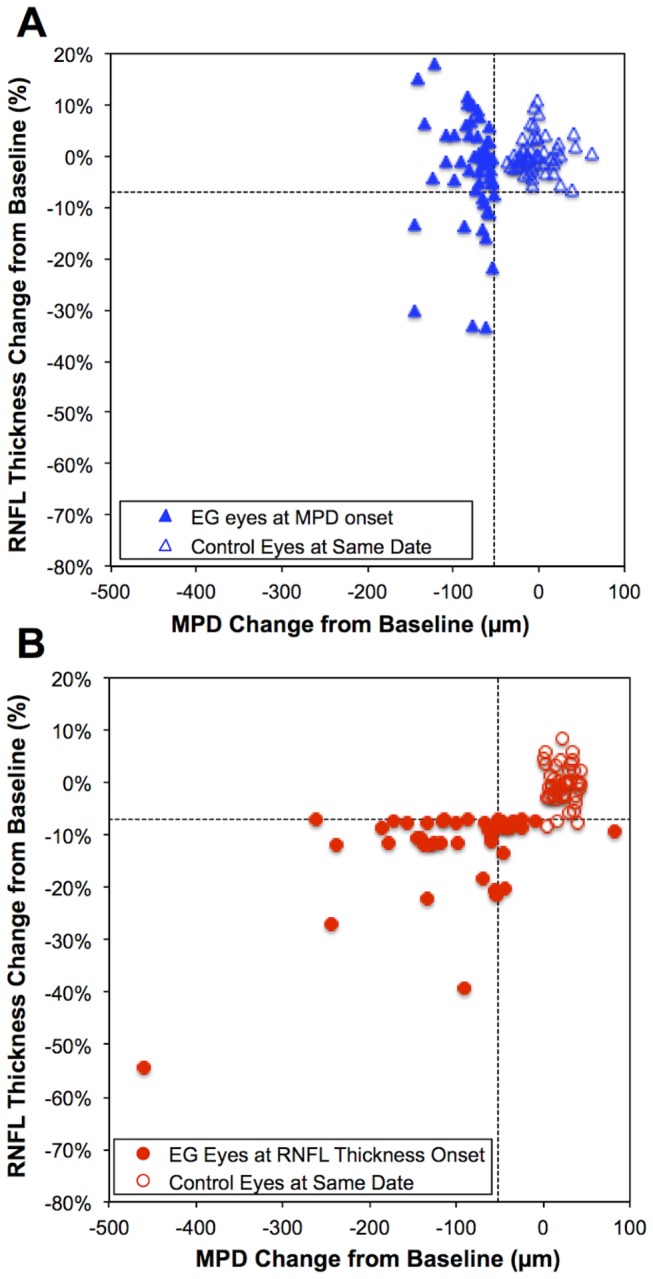
Comparison of RNFL thickness and MPD at onset of change for each parameter.(A) The magnitude of change in RNFL thickness from baseline is plotted against the change in MPD from baseline for the 52 EG eyes that reached MPD endpoint (filled triangles) and their fellow control eyes (open triangles). By definition, all of the EG eyes have an MPD change greater than 52 µm (vertical dashed line). At this first, specific, detectable MPD change, the median RNFL thickness change was only 0.9% below from baseline and only 13 (25%) of EG eyes exhibited an RNFL thickness change beyond the measurement noise limit of -7% (horizontal dashed line). (B) The same parameters as in panel A are plotted for the 44 EG eyes that reached RNFL thickness endpoint and their fellow control eyes at the onset of RNFL thickness change (the session immediately prior to RNFL thickness endpoint). By definition, all of the EG eyes have an RNFL thickness decline greater than 7% (horizontal dashed line); in this case, three of the control eyes exhibited change this large or greater. At this first, specific, detectable change in RNFL thickness, MPD had already moved posteriorly from baseline by an average of 101 µm and 32 (71%) of EG eyes exhibited a posterior MPD shift larger than the measurement noise limit of 52 µm (vertical dashed line).